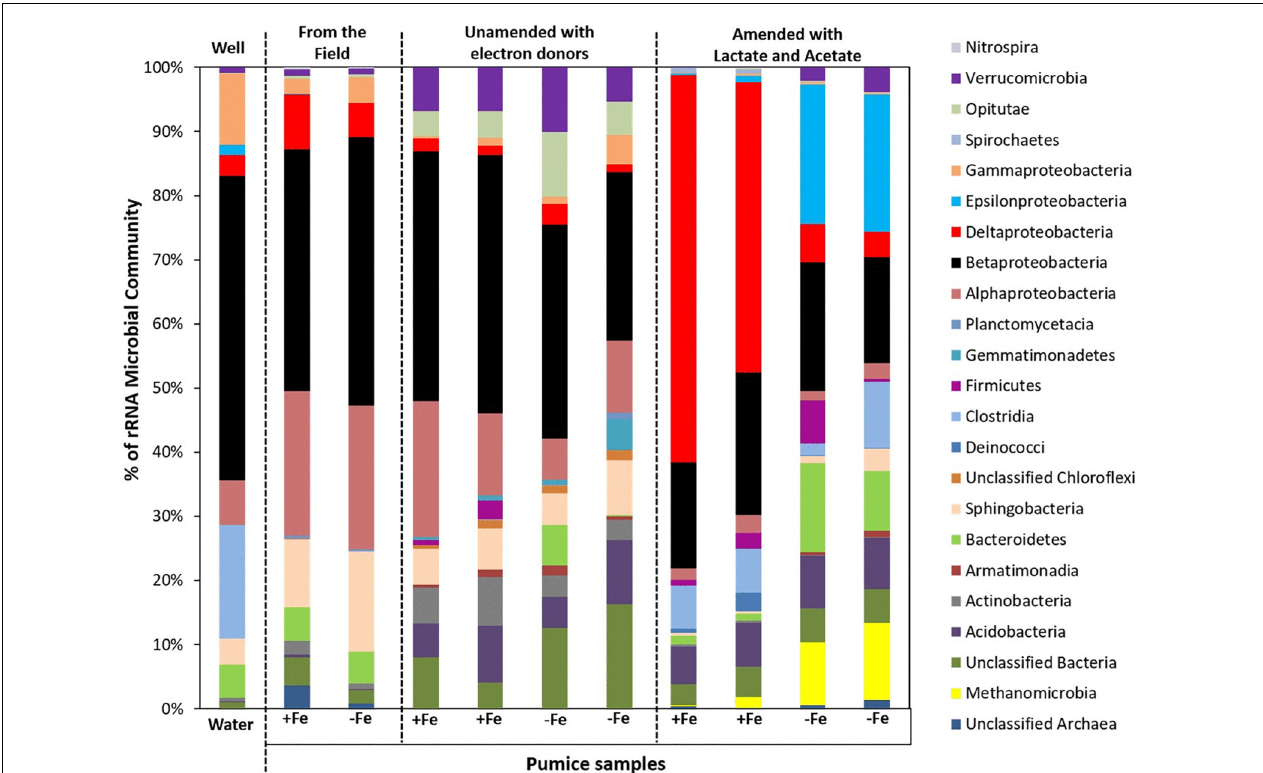
FIGURE 7 | Microbial community (Phyla/classes) in spring water and deployed pumice samples incubated (with and without electron donors) for 8 weeks at 20 ◦ C. +Fe represents Fe(III)-coated pumice and –Fe depicts uncoated pumice. Duplicates of each pumice sample were